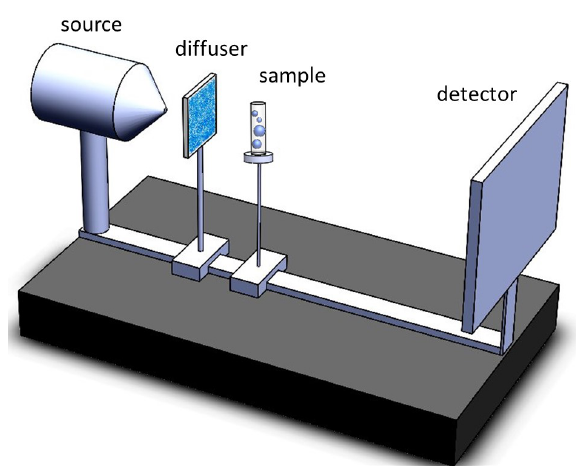
Figure 1. Depiction of the experimental setup for the X-ray speckle tracking